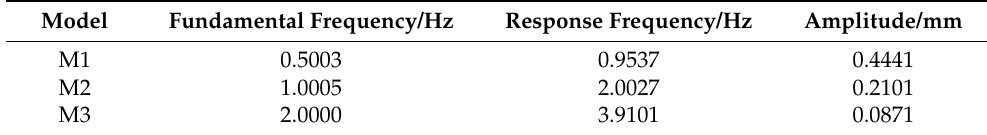
Table 6. Dynamic responses of point A of M1~M3, ω 0 = π /100 (rad/s), T = 0.1 s.